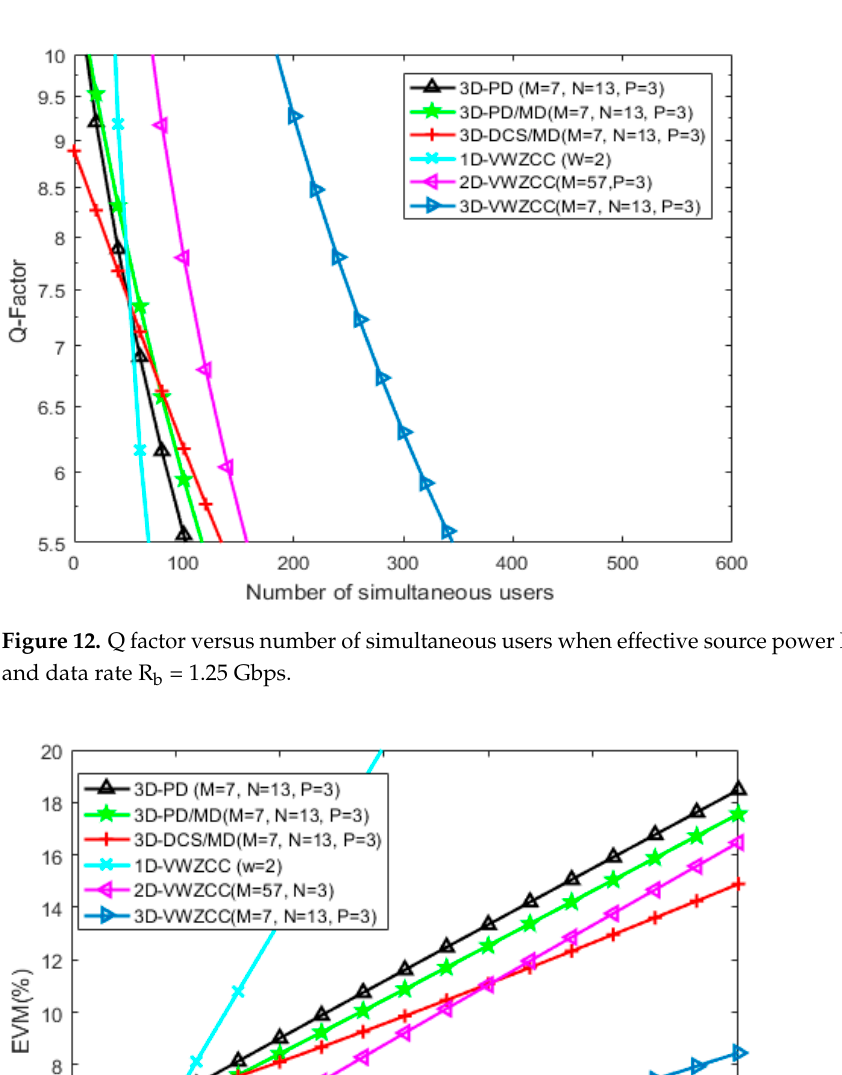
Figure 12. Q factor versus number of simultaneous users when effective source power P (cid:2929)(cid:2928) = − 10 dBm and data rate R (cid:2912) = 1.25 Gbps.